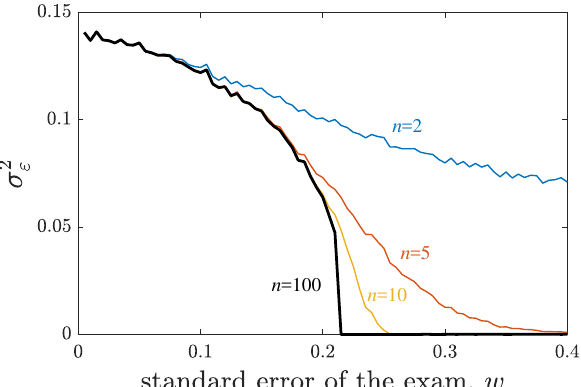
Figure 4: Variance σ 2 in the estimated ability of the prestige class for Case II, plotted (cid:34) as a function of the standard error w of the exam. Different curves correspond to different rounds n of evaluation. Data is taken from numerical simulations of a single cohort of N = 10 6 candidates. Compare Fig. 1.